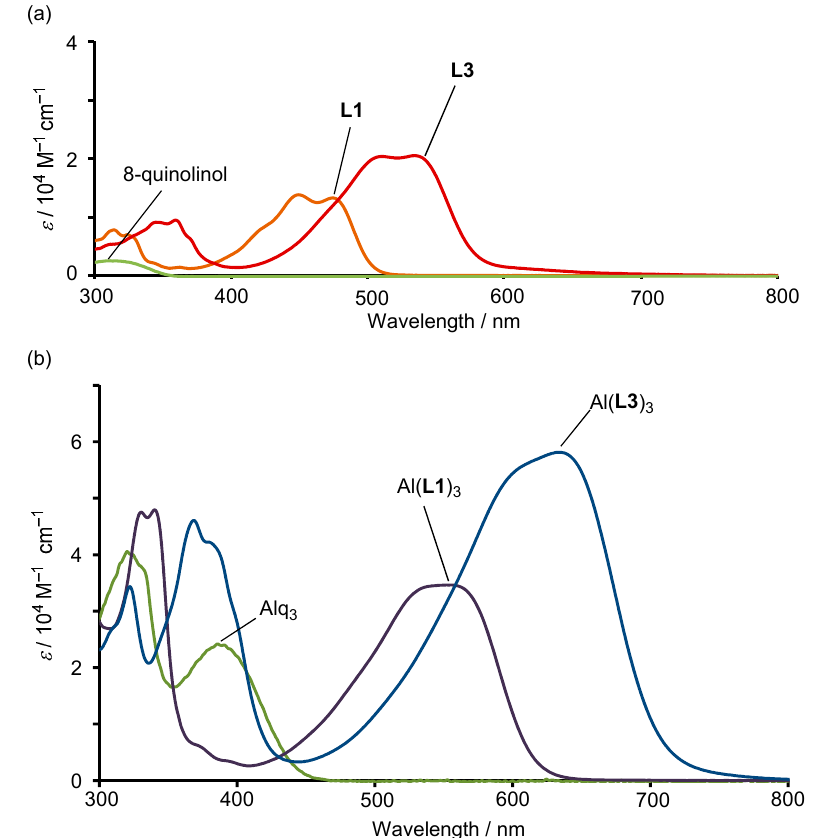
Figure 4. UV–Vis absorption spectra of ( a ) the ligands 8-quinolinol, L1 , and L3 , as well as ( b ) the aluminum complexes Alq 3 , Al( L1 ) 3 , and Al( L3 ) 3 . All spectra were measured in CH 2 Cl 2 except for that of Al( L1 ) 3 , which was measured in 1,1,2,2-tetrachloroethane (TCE) due to the low solubility of Al( L1 ) 3 in other common organic solvents.